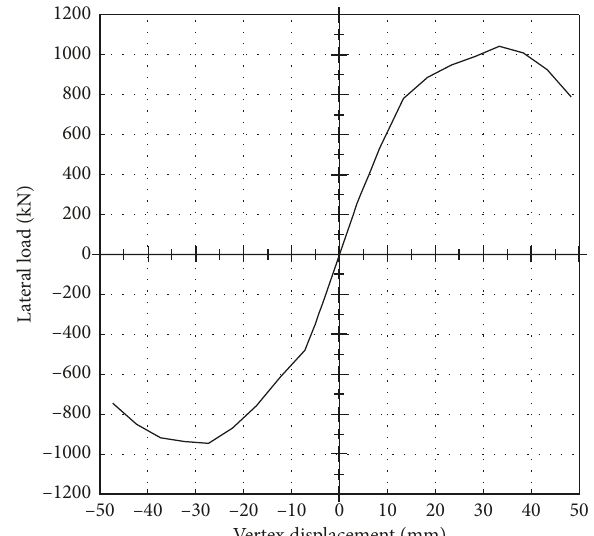
Figure 17: The lateral load-vertex displacement of the NPGCS finite-element spatial